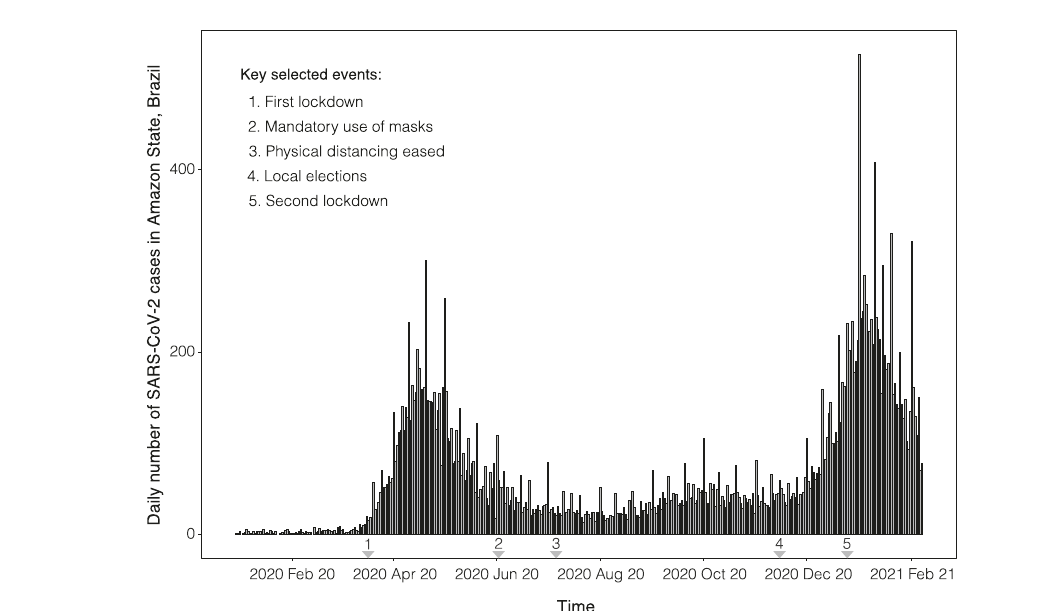
Fig. 1 | Con fi rmed incident SARS-CoV-2 cases from Hong Kong until 7th of May 2020. The arrows represent policy change-times 38 .